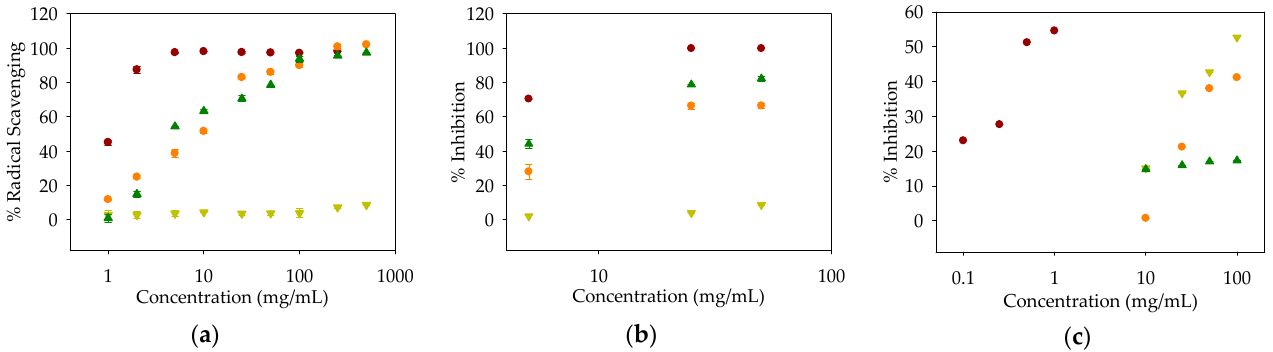
Figure 2. Dose-dependent activities of compounds 1 to 3 [control ( ); 1 ( ); 2 ( ); 3 ( )]: ( a ) DPPH radical-scavenging activity (control: L -ascorbic acid); ( b ) ABTS radical-scavenging activity (control: L -ascorbic acid); ( c ) Pancreatic lipase ac- tivity (control: orlistat). Table 4. Bioactivities of compounds 1 to 3